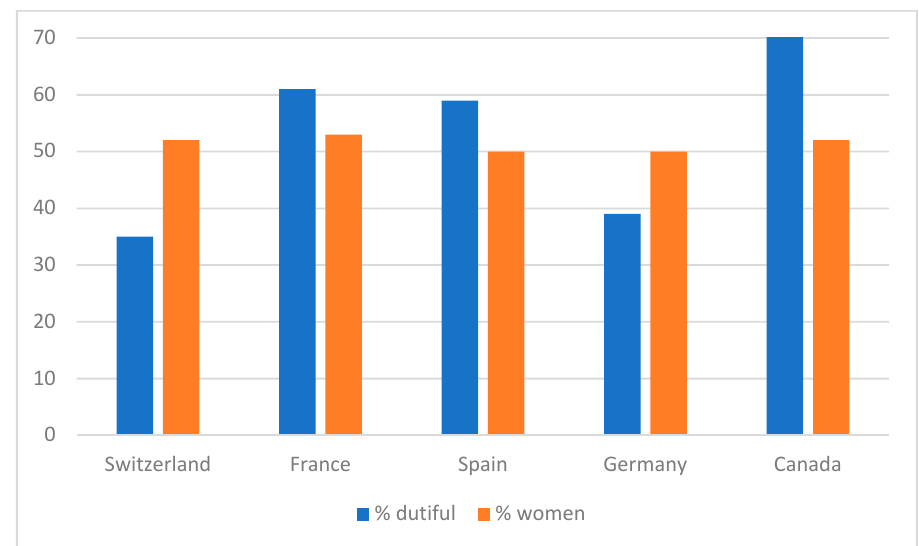
Table A2: Percent of dutiful citizens and women per country (MEDW)